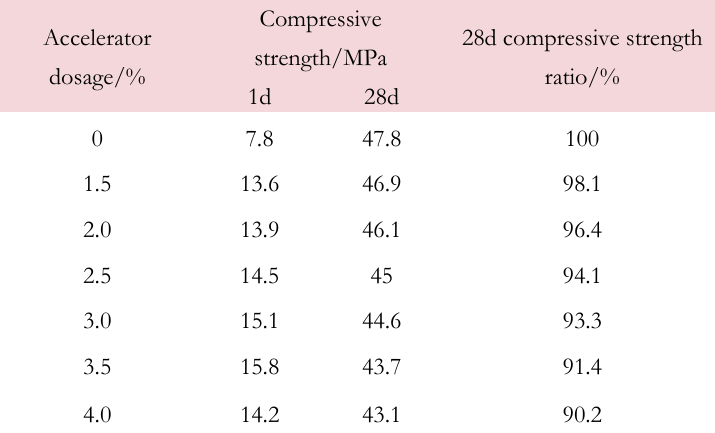
Table 2: Compressive strength of cement mortar.